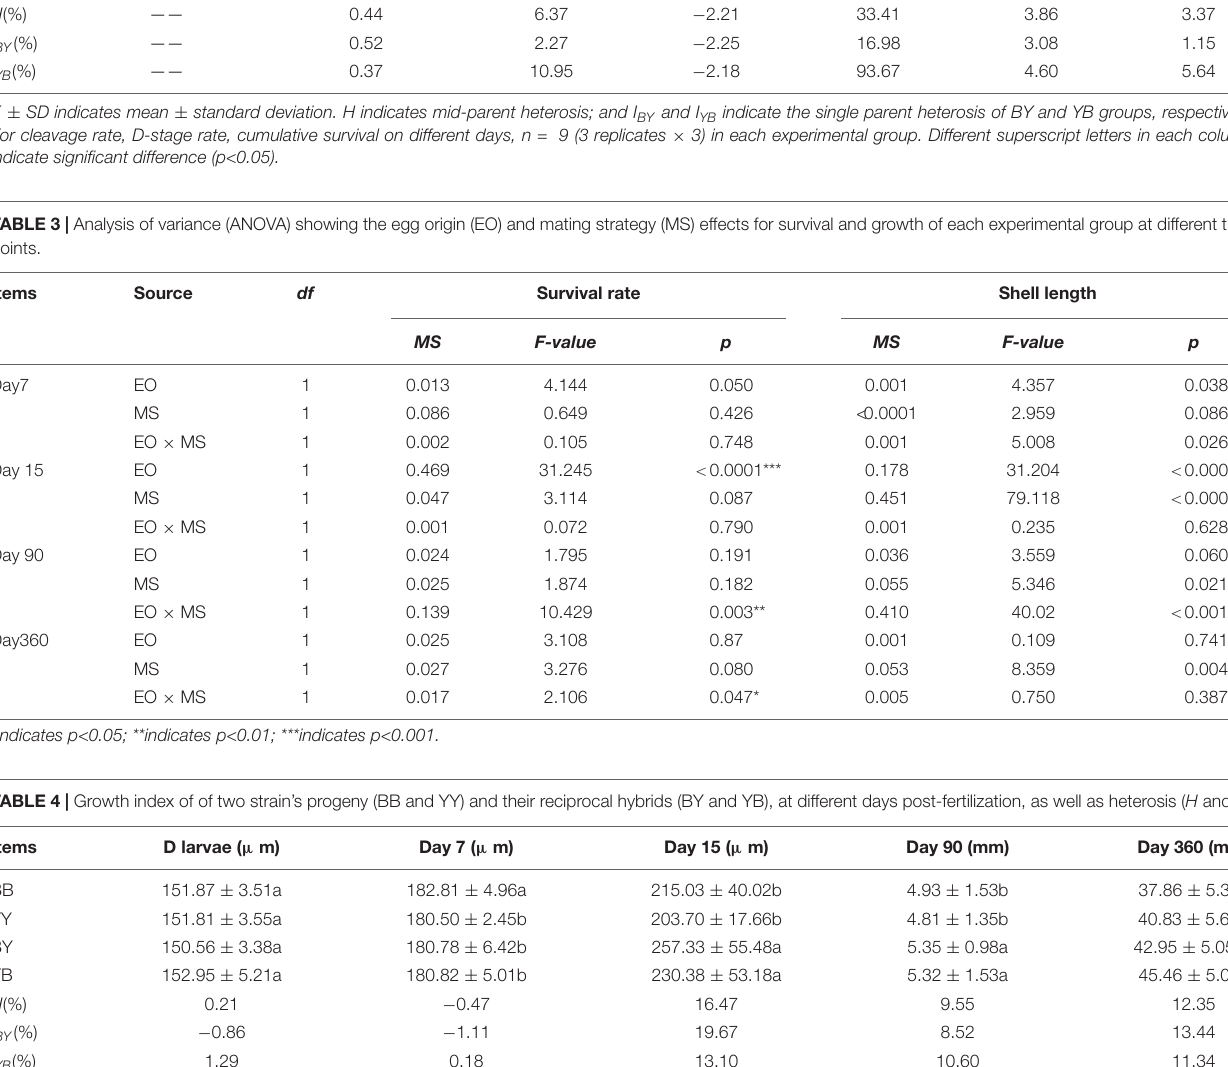
indicate significant difference (p<0.05).